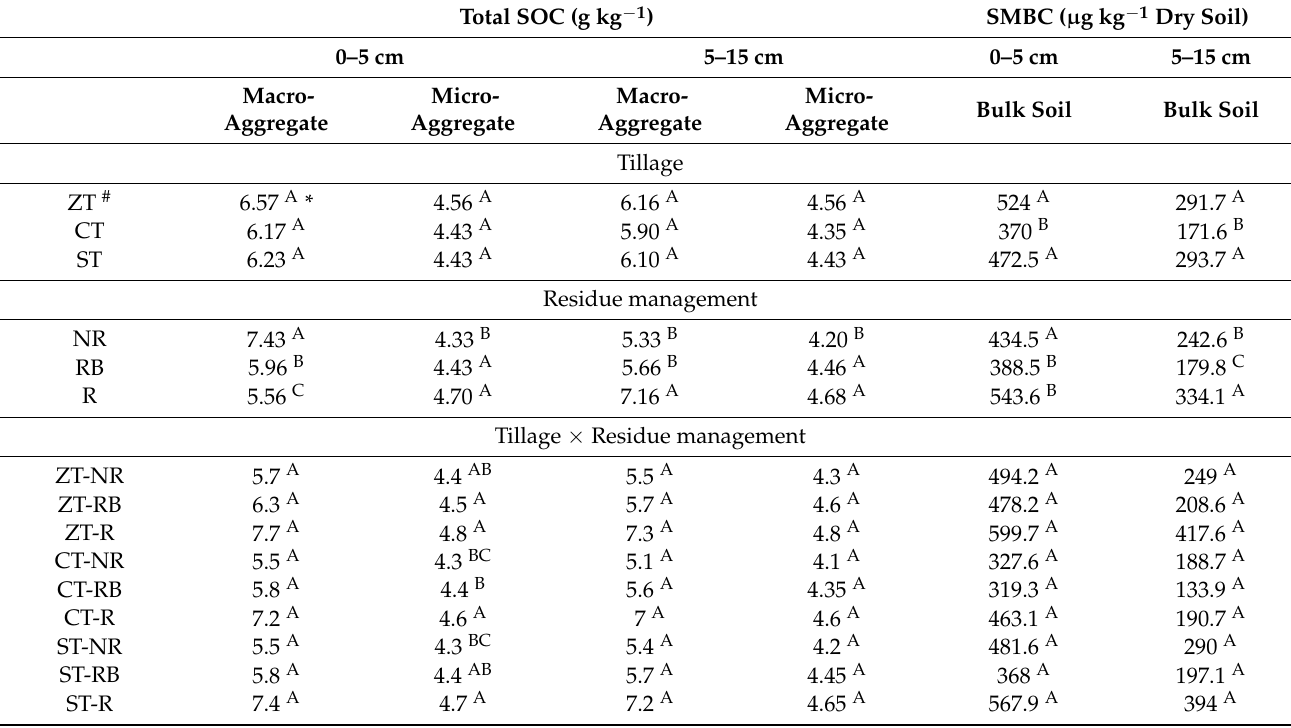
Table 1. Aggregate-associated total soil organic carbon (SOC) (g kg − 1 ) and soil microbial biomass carbon (SMBC) ( µ g kg − 1 dry soil) in bulk and aggregates as influenced by 18 years of tillage and residue management in a rice–wheat cropping system in an